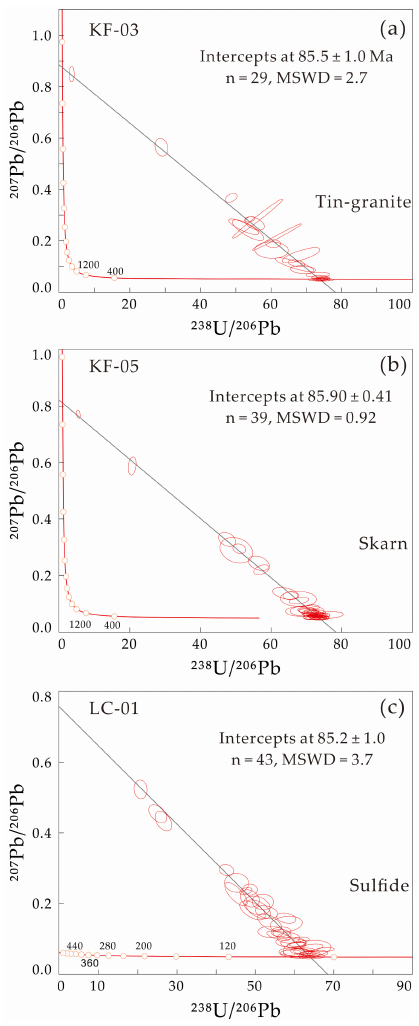
Figure 5. Tera–Wasserburg U–Pb plots for cassiterites from the Gejiu tin polymetallic deposit (the ages are calculated at 95% confidence level). ( a ) Plots reveal a mineralization age at 85.5 ± 1.0 Ma; ( b ) Plots reveal a mineralization age at 85.90 ± 0.41 Ma; ( c ) Plots reveal a mineralization age at 85.2 ± 1.0